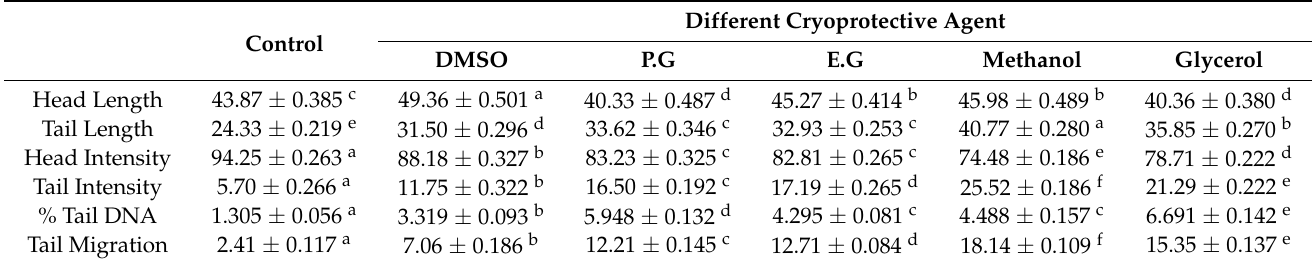
Table 1. Statistical analysis of the comet assay performed after cryopreservation of roughscale sole ( Clidoderma asperrimum ) sperm using various cryoprotective agents (CPAs). Different Cryoprotective Agent Control DMSO P.G E.G Glycerol